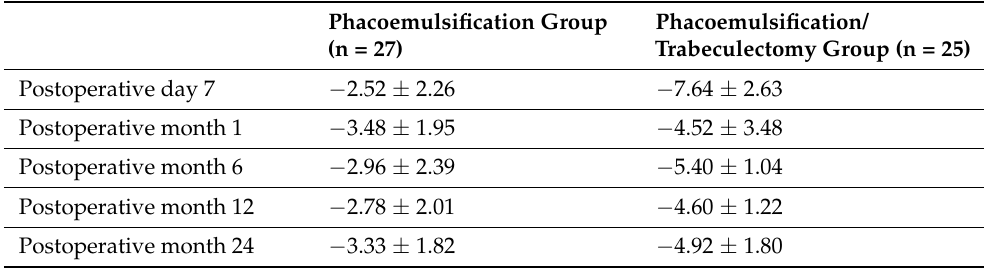
Table 2. Change in intraocular pressure at different time-points compared to baseline in the two groups.